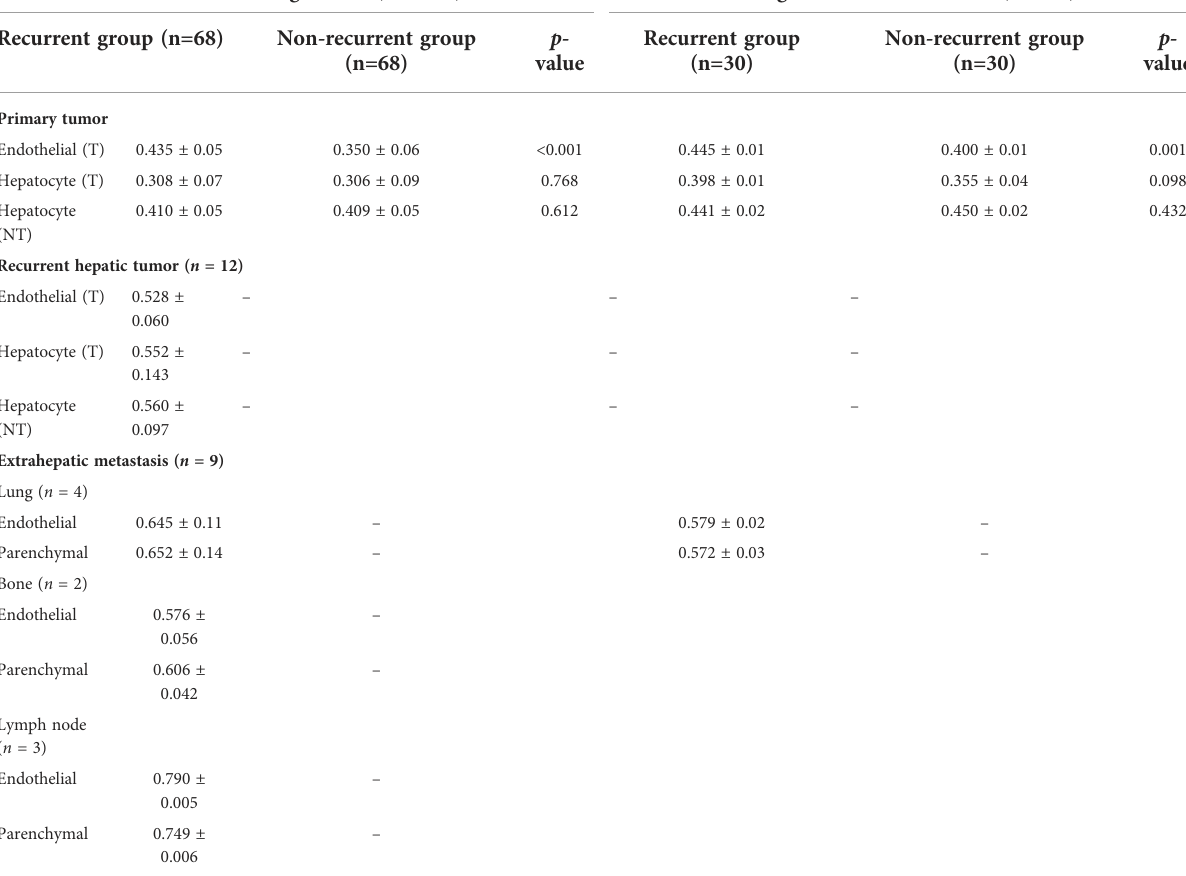
TABLE 3 Intensity of angiopoietin-2 staining (expressed as optical density [OD]) in primary tumors of recurrent and non-recurrent cases of the training and validation cohorts, and in recurrent tumors occurring in transplanted livers, and metastasis of both training and validation cohorts. Modena ’ s training cohort ( n = 140) Bologna ’ s validation cohort ( n =